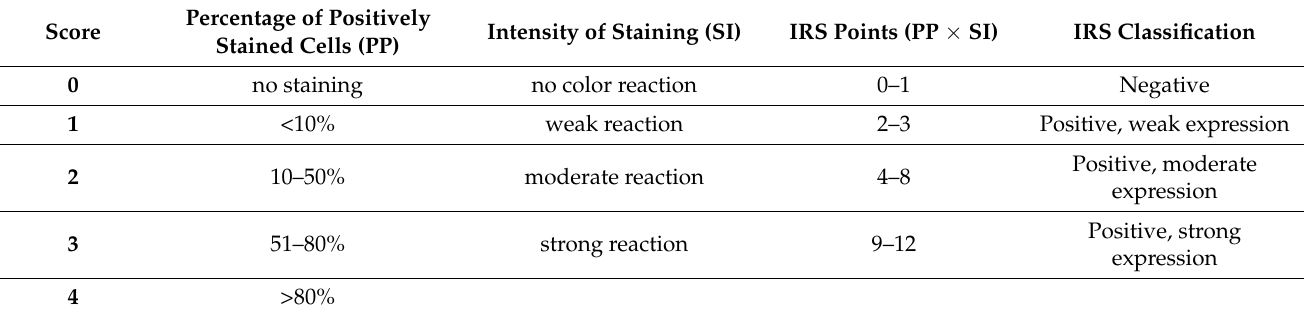
Table 2. Scoring system by Remmele and Stegner (IRS, Immunoreactive Score) taking into account the percentage of cells and the intensity of the